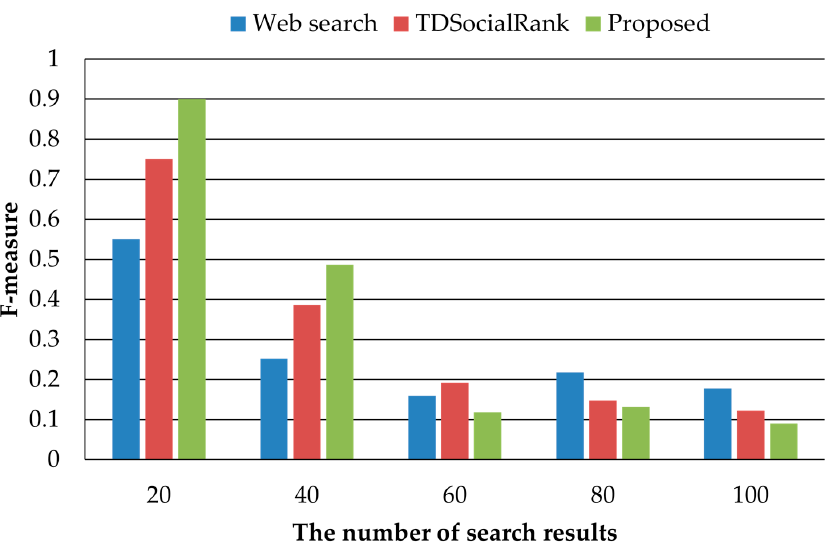
Figure 6. F-measure.